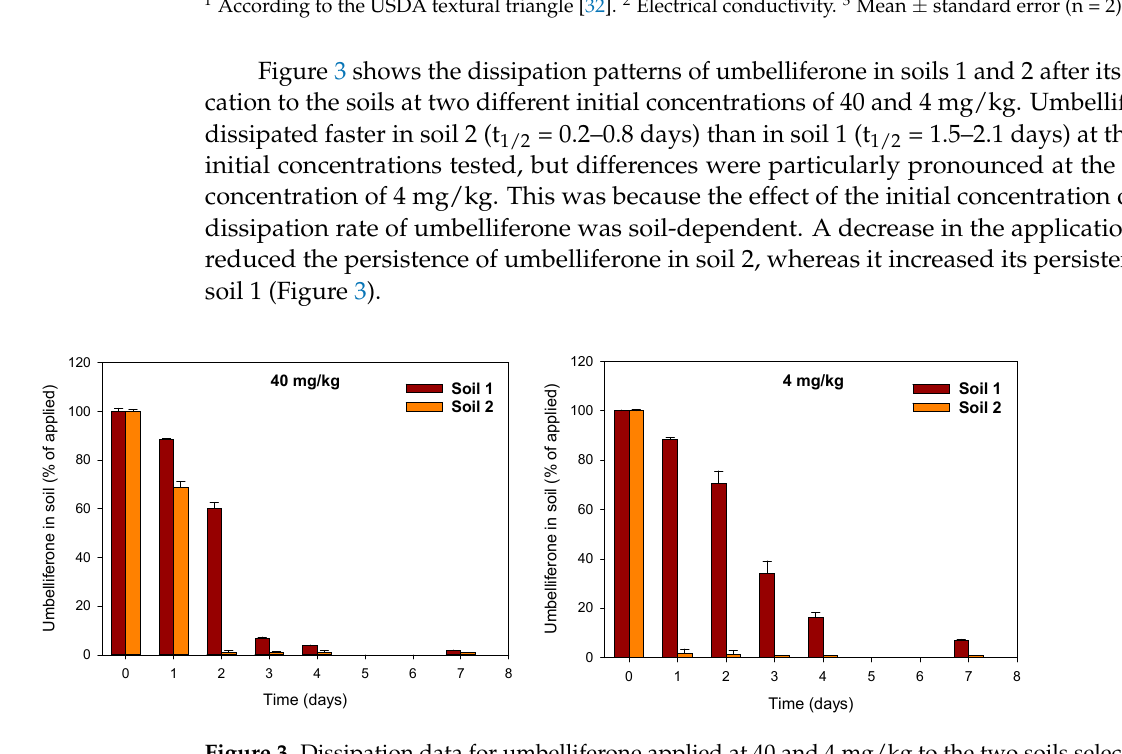
Figure 3. Dissipation data for umbelliferone applied at 40 and 4 mg/kg to the two soils selected for the study.